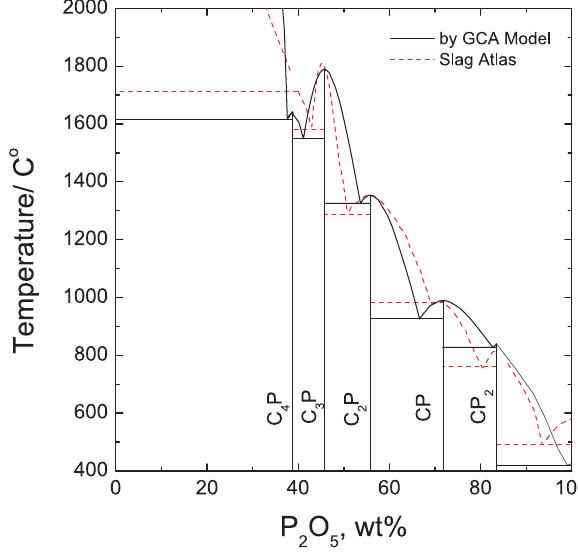
Fig. 1: Comparison between the calculated liquidus by the GCA model and the published data [10] in the CaO-P